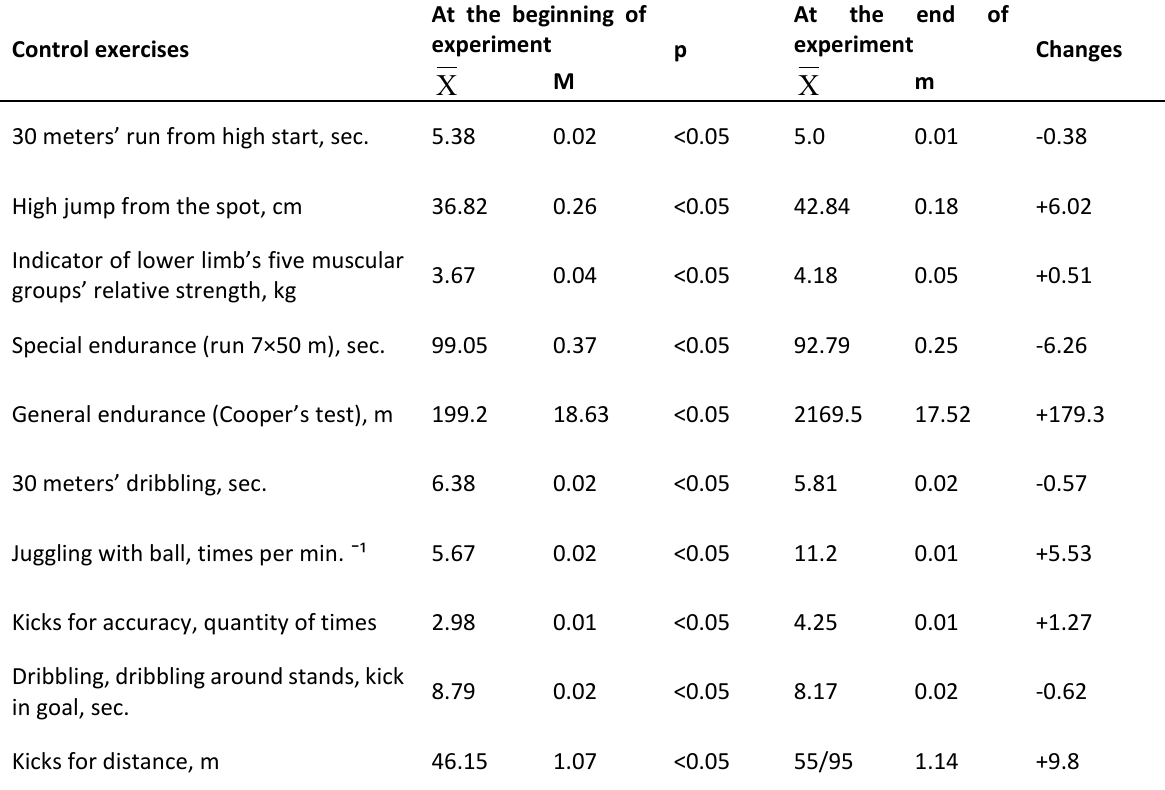
Table 1. Changes in physical and technical fitness levels in group 1 girl students at the end of comparative